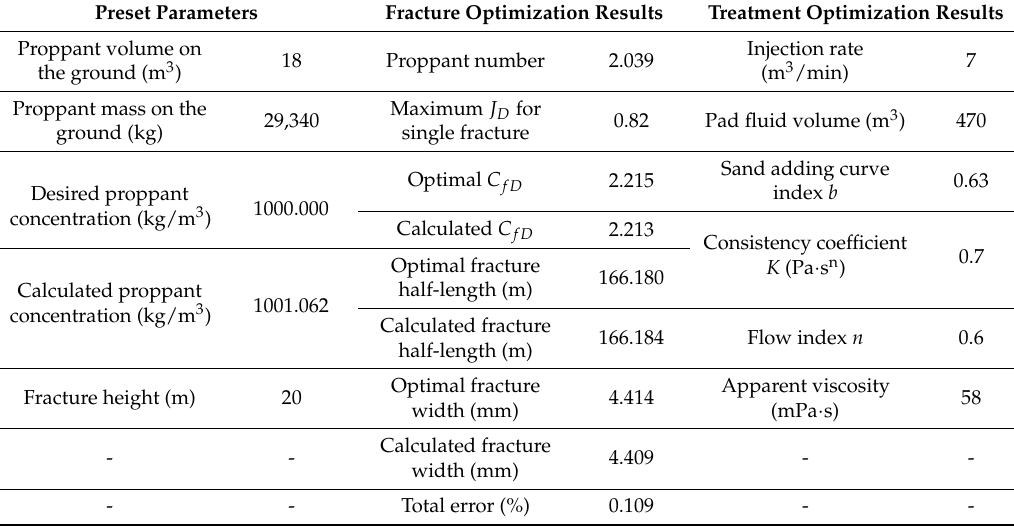
Table 3. Optimization results.